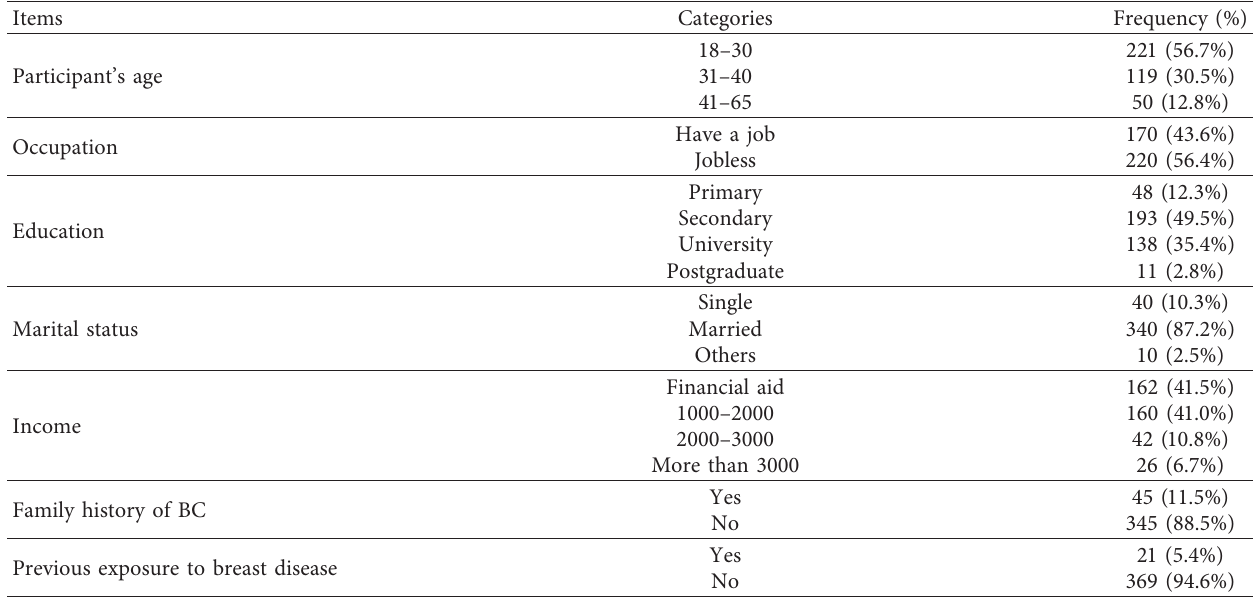
Table 1: Biographical data and cancer